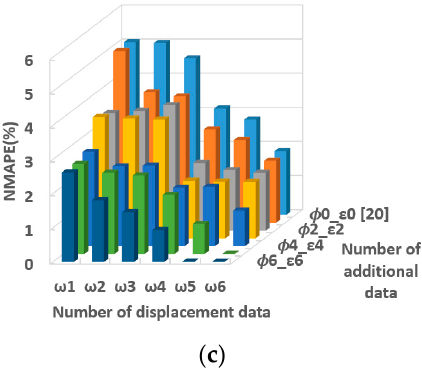
Figure 27. NMAPE according to the number and combination of sensors (RDS2): ( a ) displacement + slope, ( b ) displacement + strain, ( c ) displacement + slope + strain.